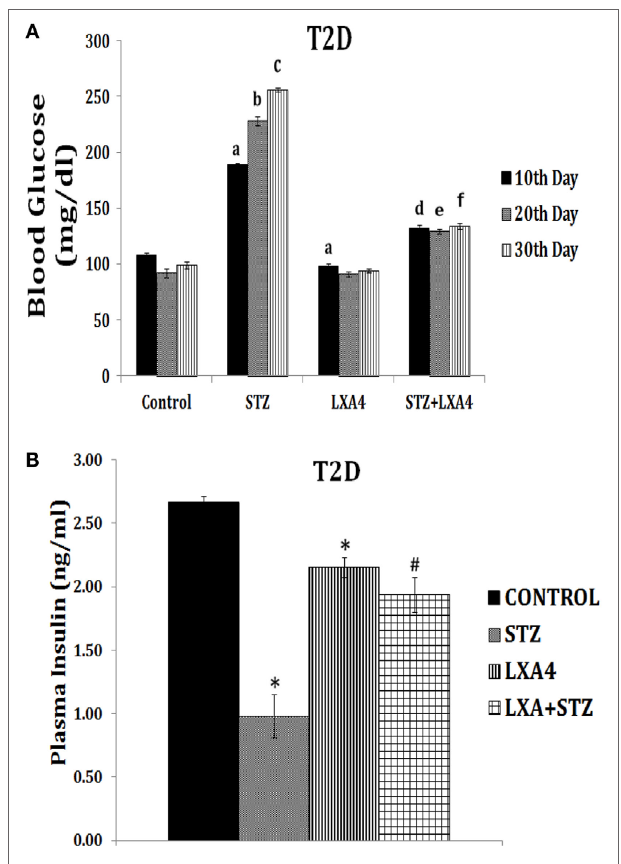
FiGUre 13 | Effect of lipoxin A4 (LXA4) against streptozotocin (STZ)-induced type 2 DM in Wistar rats. Protocol of the study : after 7 days of acclimatization, type 2 DM was induced by intraperitoneal administration of STZ 175 mg/kg of body weight, which is considered as day 1 of the study. LXA4 60 ng/animal was given intraperitoneally on day 1 (the day STZ was administered) and daily for 5 days [these data are taken from Ref. (420)]. These studies were approved by Institutional Animal Ethics committee. (a) Plasma glucose levels : plasma glucose was estimated once in 10 days till day 30, the day study was concluded. All values are expressed as mean ± SEM. a P ≤ 0.05 compared to control values of day 10. b P ≤ 0.05 compared to control values of day 20. c P ≤ 0.05 compared to control values of day 30. d P ≤ 0.05 compared to STZ values of day 10. e P ≤ 0.05 compared to STZ values of day 20. f P ≤ 0.05 compared to STZ values of day